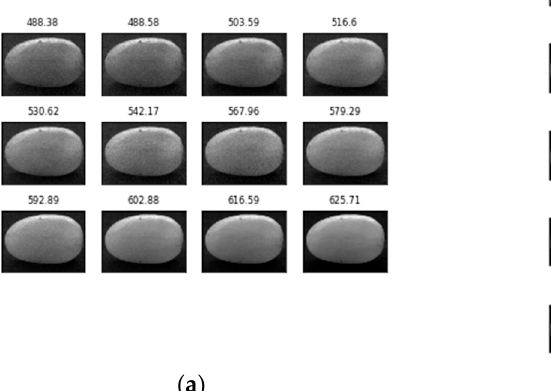
Table 2. Transformation ranges of data augmentation. Transformation Range Brightness